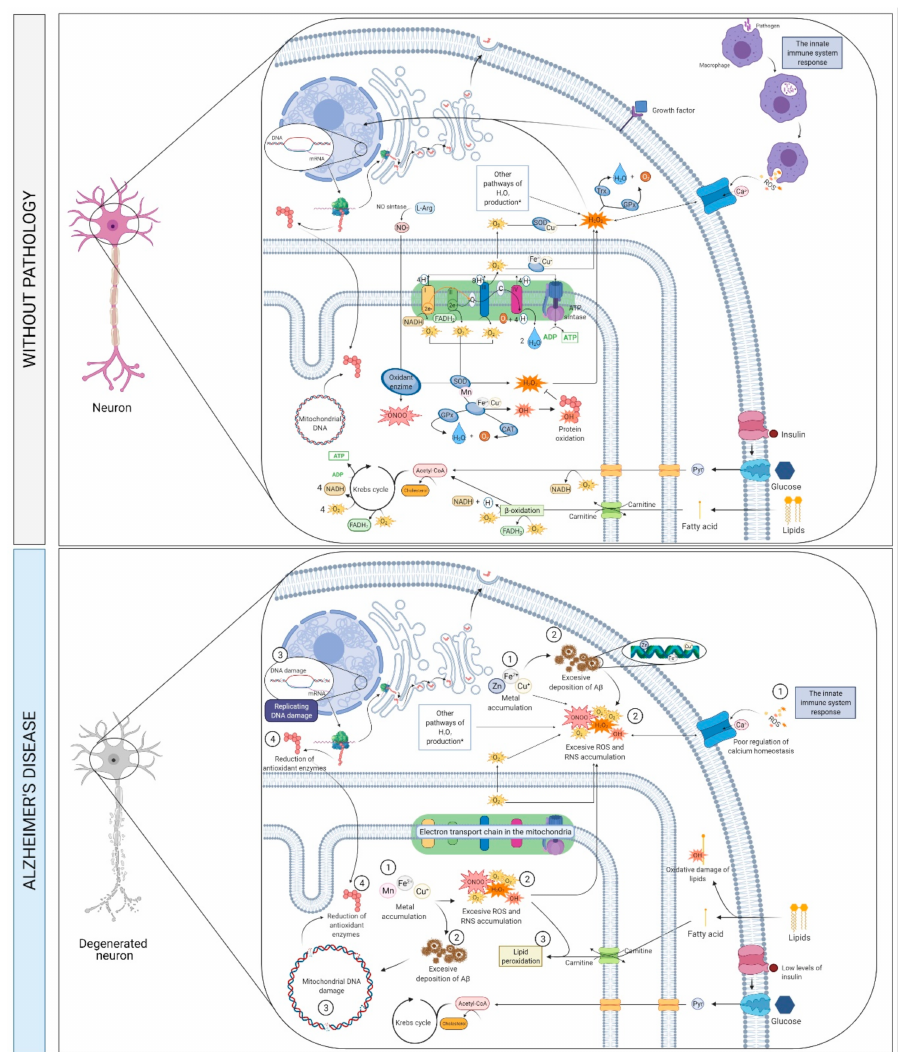
Figure 6. Metabolism, oxidative stress and neurotoxicity pathway. Abnormal accumulation of A β plaques, loss of mitochondrial function, increased production of ROS, metal dyshomeostasis, and diminished antioxidant protection mechanisms are all occurring during the progression of AD pathophysiology. Mitochondria participate in multiple cellular/molecular activities, such as energy metabolism, ATP synthesis, Ca 2+ signaling, and iron (among other metals) homeostasis. Therefore, neuronal viability is greatly dependent on mitochondrial activity. Thus, mitochondrial deficiencies are frequently detected in neurodegenerative diseases, including AD. Since mitochondria are the primary source of ROS, any abnormality in the proper function of the electron transport chain results in damage of a number of biomolecules (i.e., proteins, lipids, nucleic acids). In patients with AD, A β accumulation is associated with impairment of mitochondrial activity, decreased oxidative phosphorylation, and ROS generation. As a result, a reduction of energy supplies is observed. In AD brains, ROS levels are significantly more elevated than in healthy brains. During the generation of A β plaques, several ROS species are produced; particularly, H 2 O 2 is one of the most relevant ROS species. The ROS/H 2 O 2 production further triggers production and aggregation of A β , which, in turn, can lead to ROS/H 2 O 2 generation. Bidirectional interactions between ROS and Ca 2+ signaling pathways are typical: ROS is able to modulate cellular Ca 2+ signaling, which in turn is crucial for ROS production. Hence, increased levels of Ca 2+ activate the enzymes responsible for the creation of ROS and free radicals. The ROS-Ca 2+ interplay participates in several pathophysiological conditions, for instance AD, Parkinson’s disease, inflammatory diseases, and cancer. AD patients also show altered homeostasis of metals, including iron, copper, or zinc, that damages the cell redox system and promotes oxidative load as well as an increased deposition of extracellular A β plaques. Oxidative load induces the production of elevated amounts of end-products of lipid peroxidation, various different oxidized proteins, and oxidative alterations in both nuclear and mitochondrial DNA. Abbreviations: A β , amyloid beta; AD, Alzheimer’s disease; Ca 2+ , calcium; H 2 O 2 , hydrogen peroxide; ROS, reactive oxygen